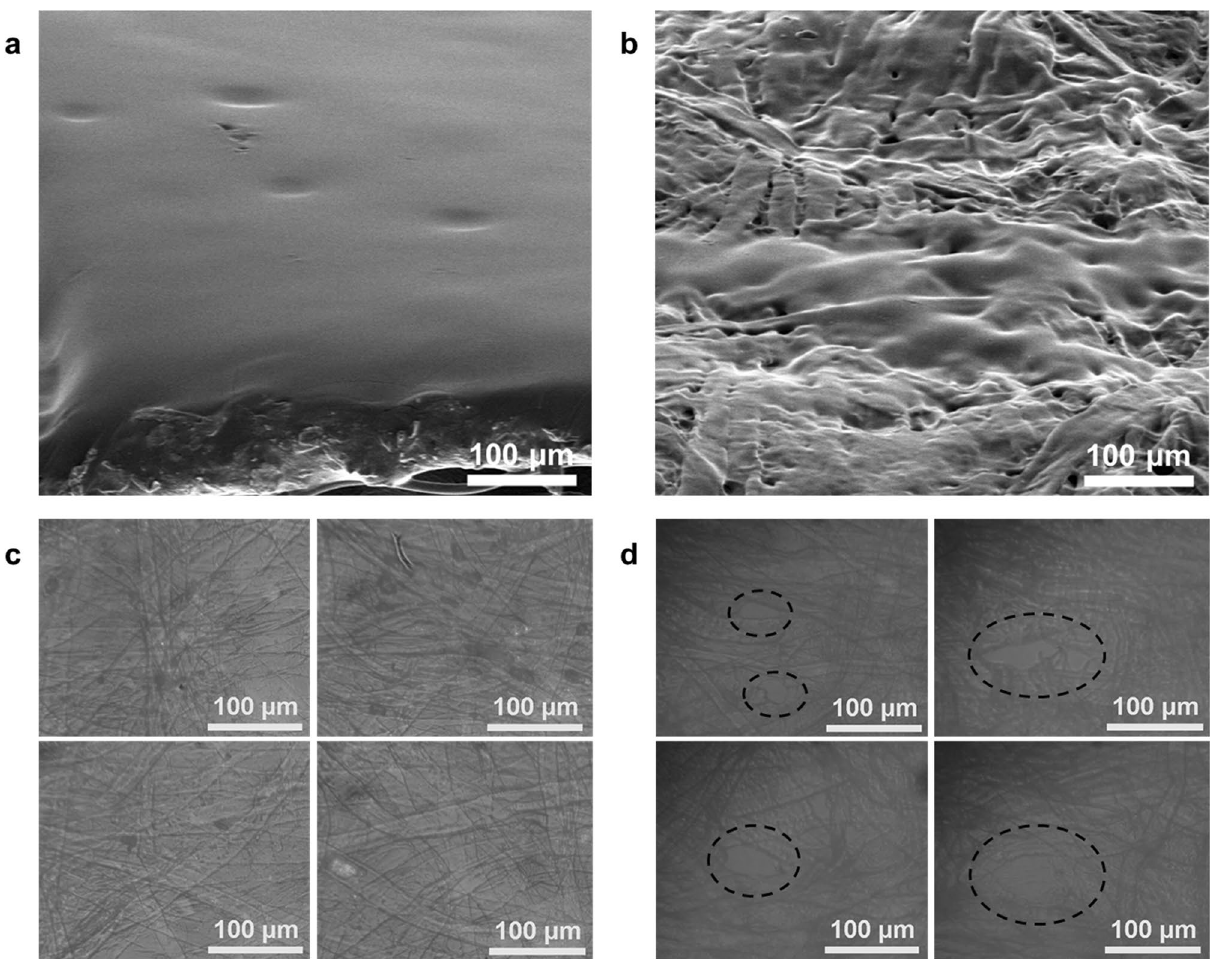
Figure 1. Images of polyvinyl alcohol (PVA) tape observed by ( a , b ) Scanning electron microscope and ( c , d ) optical microscopy. ( a , c ) Prior to loading solution; and ( b , d ) after loading solution. The surface of the PVA tape exposing to water is pitted, and collapsed structure and sizable holes were observed (dotted circles). The SEM images are 60° tilted (10% DMSO/PBS (v/v)) and signal amplification solution were consecutively loaded at the sample pad and he signal amplification pad, respectively. In the case of using a bare membrane, NC membrane, Vivid membrane, and MMM membrane, the signal amplification was occurred within 1 min. In contrast, a delayed-release effect was observed when PVA tape was used, and the signal amplification was started after approximately 5 min (Fig. 2 and Fig. S2). These results confirm that the PVA tape induced a superior delayed-release effect compared to the other membranes, and thus could be appropriately used as a signal amplification platform based on its delayed-release property. The PVA tape was also compared to a general double-sided tape to further investigate the observed ion dif- fusion effect. For the comparison, the double-sided tape was placed between the signal amplification pad and membrane, and the same structure using PVA tape instead of the double-sided tape was prepared. The sample and amplification solutions were applied to the sample and signal amplification pads, respectively. No signal appeared over time on the strip with the general double-sided tape, whereas the signal intensity increased on the strip with the PVA tape at approximately 5–7 min after loading the sample and amplification solutions (Fig. S3a). A comparison of the resulting signal intensities (Fig. S3b) confirmed that only the PVA tape permitted ion diffusion. The ion-diffusion permissible property of PVA tape may be attributed to its water-solubility. To confirm this, the general double-sided and PVA tapes (size 3.8 × 8.0 mm 2 ) were exposed to water, and the weight was measured at different time points. Each tape was completely dried in an oven to reduce deviation, and the weight was meas- ured using an ultra-microbalance. The general double-sided tape showed no change in weight after exposure to water. Whereas the weight of the PVA tape decreased with the time of exposure to water, decreasing by 19.5% after 5 min (Fig. S3c). Thus, the ion diffusion permissible property of PVA tape was attributed to water dissolution. Automatic signal amplification using PVA tape. To verify an automatic signal amplification using PVA tape, the signal intensities of a conventional LFI and PVA tape-applied LFI were compared. Regarding the conventional